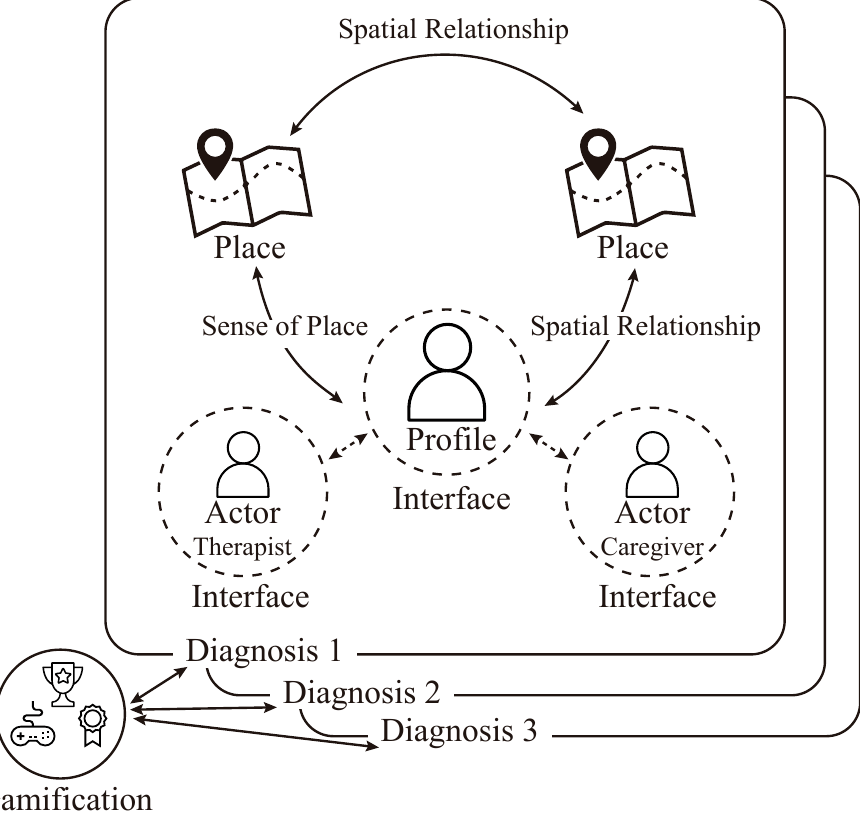
Figure 3. Relationships between dimensions. The diagnosis dimension drives the remaining dimensions, since different diagnoses bring different ways of organizing the other dimensions to design context-aware mobile applications as intervention